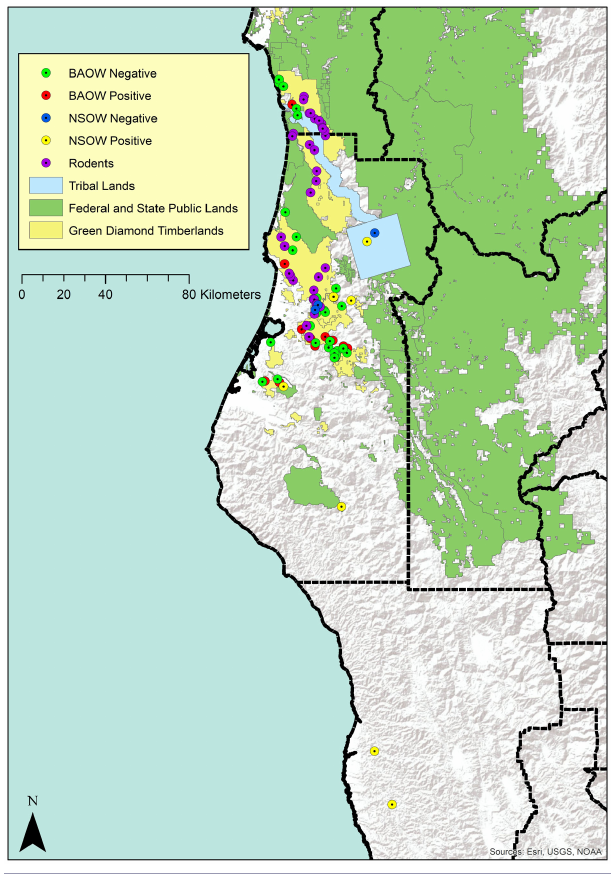
Fig. 1 . Collection locations for Northern Spotted Owls (NSO; Strix occidentalis caurina ), Barred Owls (BO; Strix varia ), and rodents and their anticoagulant rodenticide (AR) status in Northwestern California, USA. Positive NSO and BO are represented by yellow and red circles, respectively. The northern study area in Del Norte County and the southern study area in Humboldt County are delineated by dashed county lines.